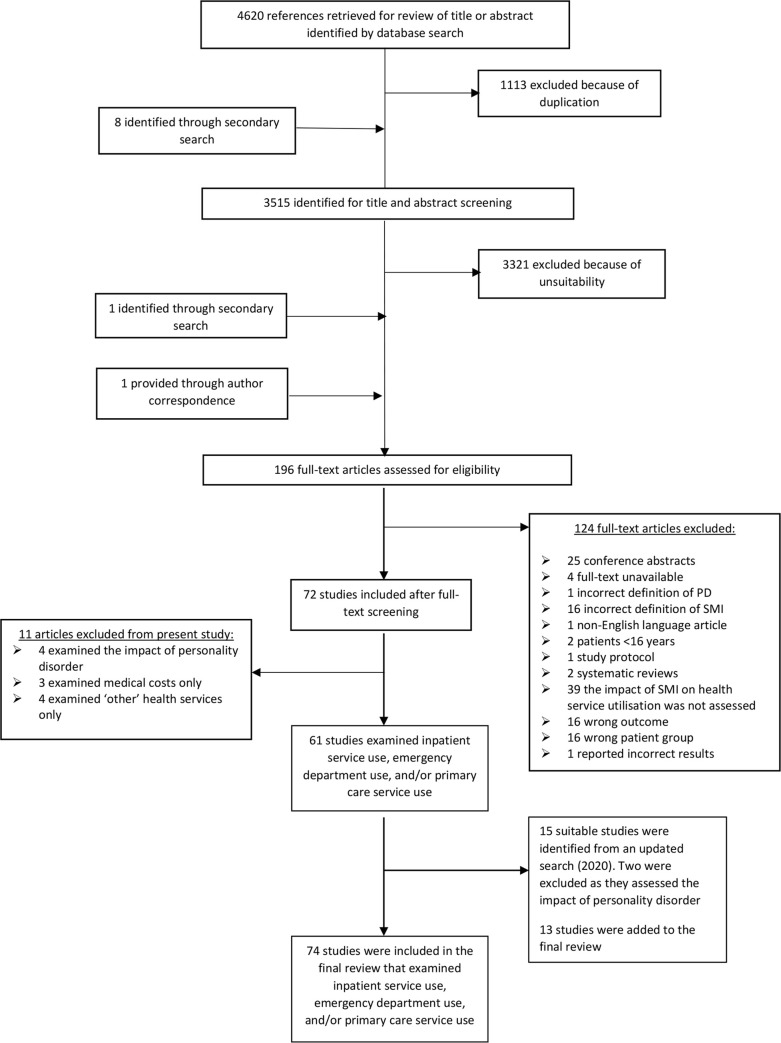
PRISMA flowchart of study selection.PRISMA, Preferred Reporting Items for Systematic Reviews and Meta-Analysis; SMI, severe mental illness.